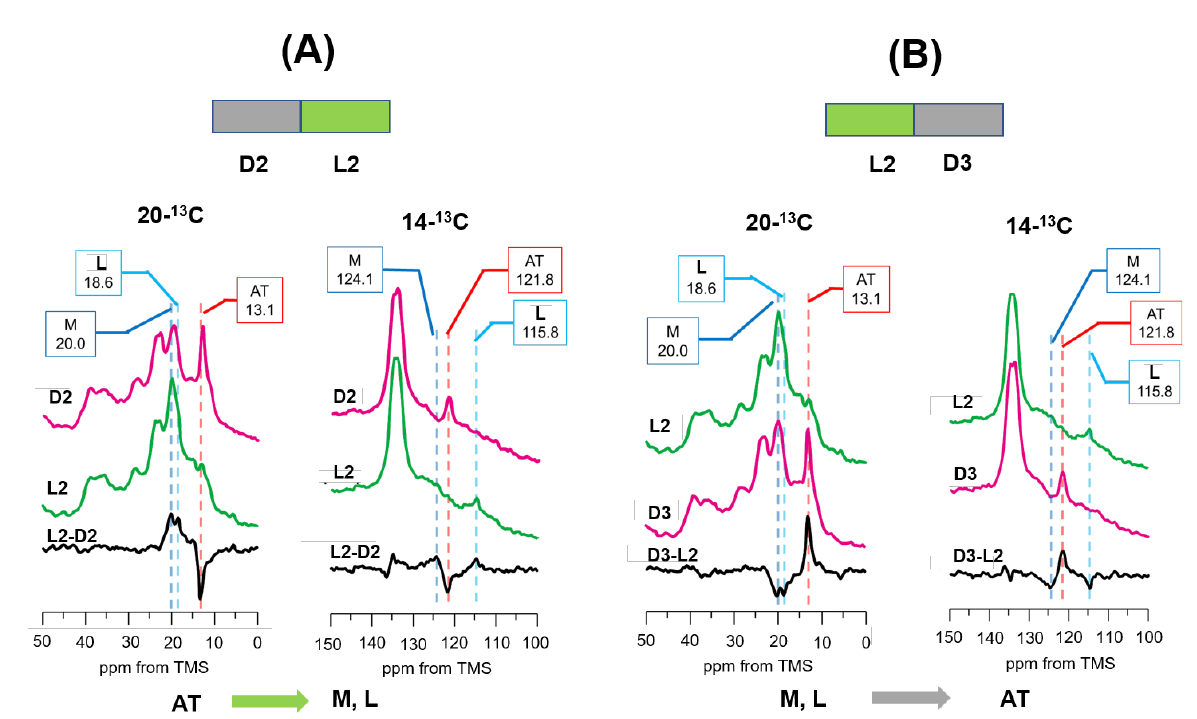
Figure 6. ( A ) Photo reaction pathways of [20- 13 C, 14- 13 C]retinal-D96N-BR under green light illumi- nation from the light-adapted D2 condition at − 30 °C. 13 C CP-MAS NMR spectra were recorded in the dark (D2; 20- 13 C and 14- 13 C) and then green light (L2; 20- 13 C and 14- 13 C), and the difference in spectra between L2 and D2 (L2-D2; 20- 13 C and 14- 13 C) indicated that the AT state changed to the M and L intermediates. ( B ) Photoreaction pathways of [20- 13 C, 14- 13 C]retinal-D96N-BR in the dark from the L2 condition at − 30 °C. 13 C CP NMR spectra were recorded under green light (L2; 20- 13 C and 14- 13 C) and then in the dark (D3; 20- 13 C and 14- 13 C), and the difference in spectra between D3 and L2 (D3-L2; 20- 13 C and 14- 13 C) indicated that the M and L intermediates changed to the AT state.